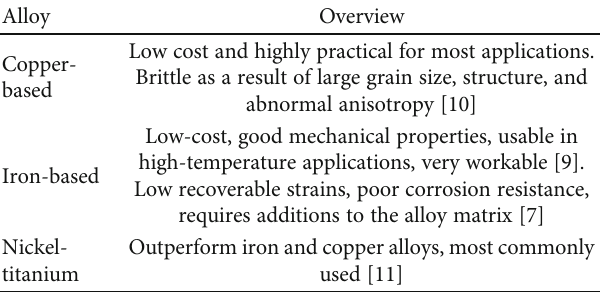
Table 1: Types of common shape memory alloys.